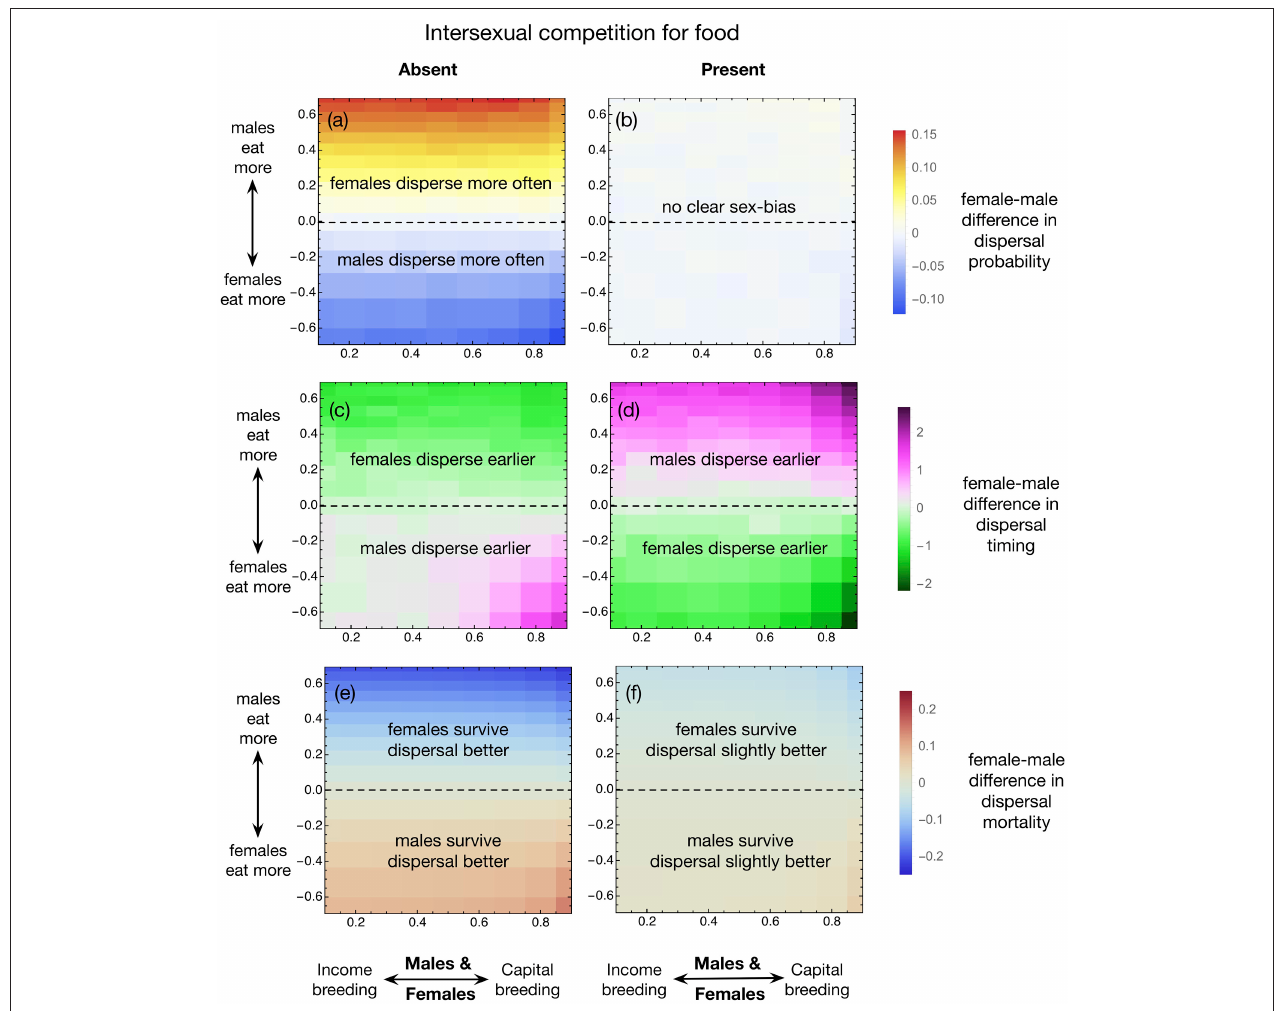
FIGURE 1 | Female-male difference between (a,b) equilibrium dispersal probability, (c,d) dispersal timing, and (e,f) dispersal associated mortality, in the absence (left panels) or presence (right panels) of intersexual competition for food. In each panel, the x -axis represents the income/capital breeding parameter ( b m = b f ), and the y -axis represents the relative food consumption of males to females [ln( β )]. Simulation parameteres: S = 1,000, n = 8, µ = 0.01, m 0 = 0.1, T = 20, R = 8, R f = R m = 4, β ranges from 0.5 to 2 with steps equal to 0.1, b m = b f range from 0.1 to 0.9, also with steps equal to 0.1. Each simulation is run for 22,000 generations and the value in each pixel is calculated as the mean of the last 20,000